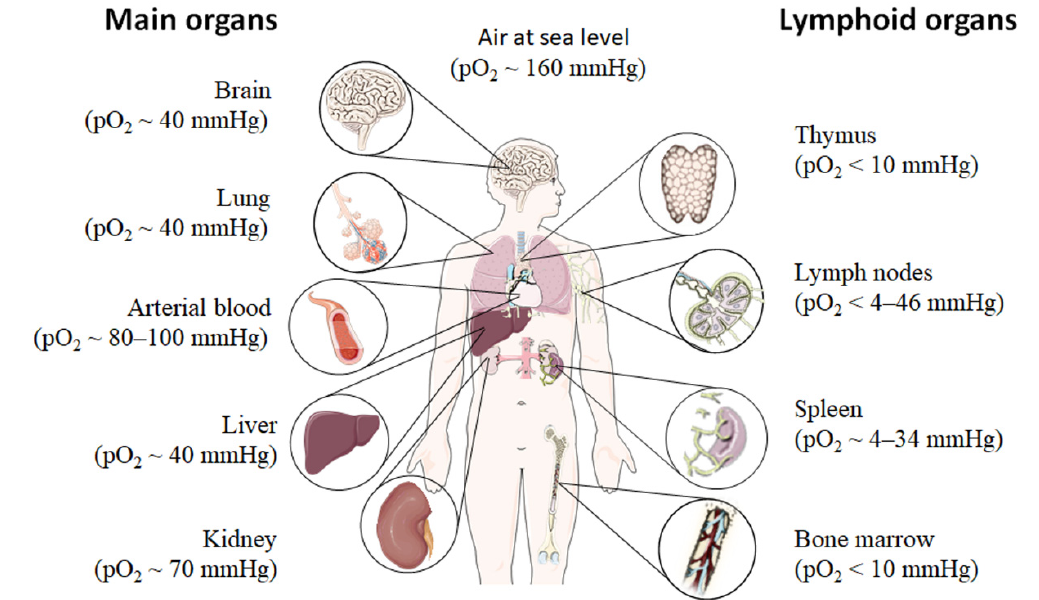
Figure 1. Oxygen partial pressure (pO 2 ) varies throughout the human body from main organs to lymphoid tissues. Figure was modified from Servier Medical Art, licensed under a Creative Common Attribution 3.0 Generic License [16] .